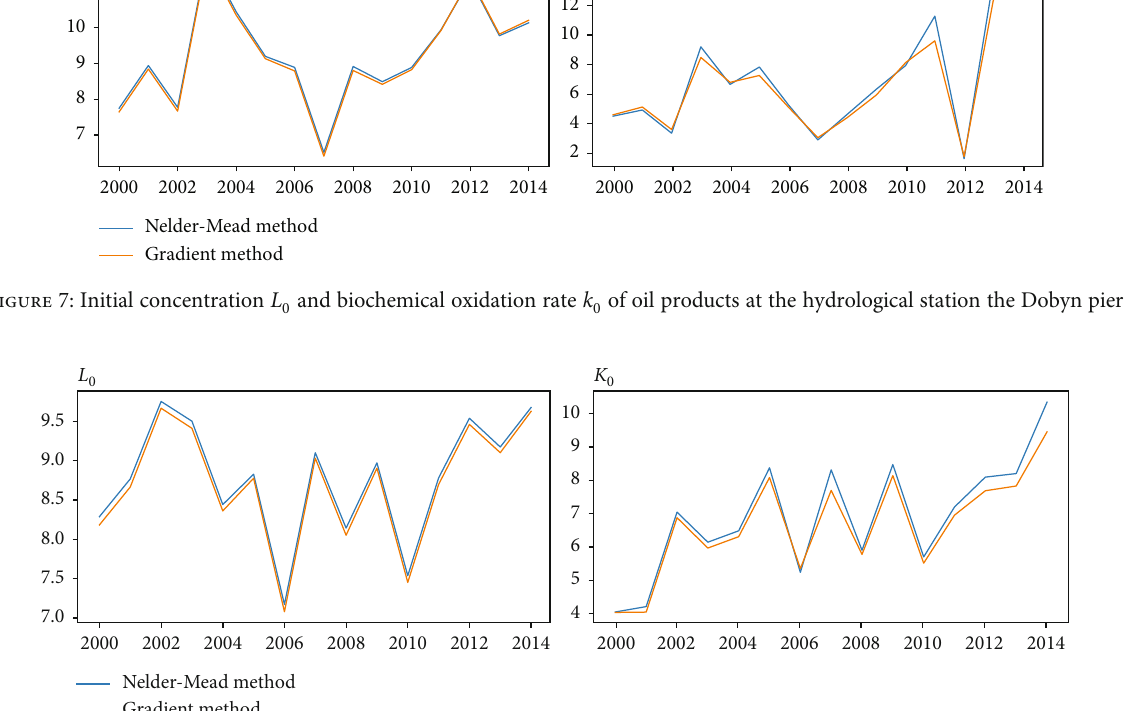
k Figure 8: Initial concentration L 0 and biochemical oxidation rate 0 of oil products at the hydrological station in the village of